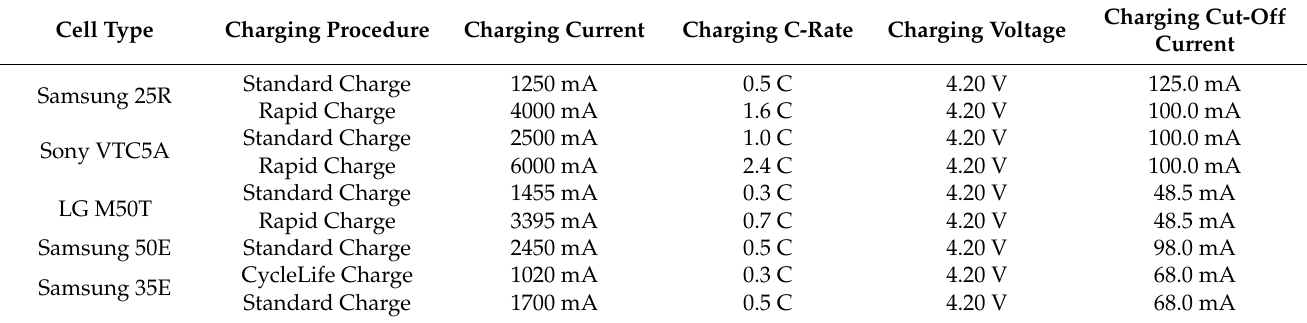
Table 4. Charging parameters and charging methods of the cycle test.